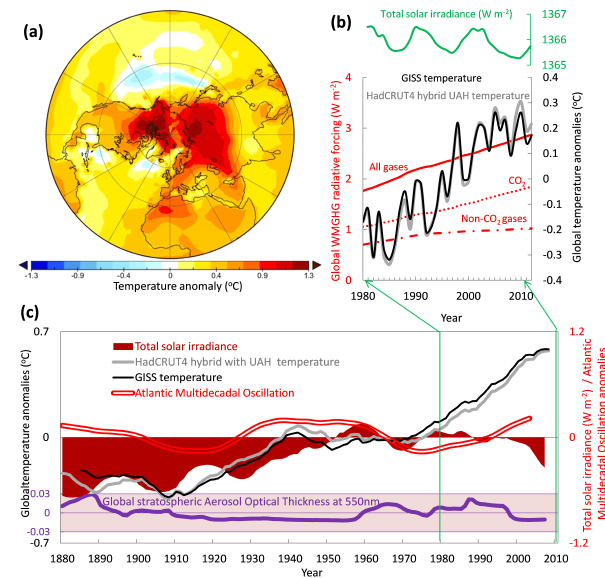
Figure 1. (a) 1980–2012 surface temperature anomaly ( ◦ C) of Northern Hemisphere relative to 1951–1980 base period. (b) The global mean annual surface temperature anomalies, total solar ir- radiance, and global well-mixed greenhouse gases (WMGHG) pat- terns during the satellite era. The WMGHG includes CO 2 , major gases (CH 4 , N 2 O, CFC12 and CFC11) and a set of 15 minor long- lived halogenated gases (CFC-113, CCl 4 , CH 3 CCl 3 , HCFCs 22, 141b and 142b, HFCs 134a, 152a, 23, 143a, and 125, SF 6 , and halons 1211, 1301 and 2402). Global annual mean surface temper- atures relative to 1951–1980 base period from GISS (black) and Cowtan and Way HadCRUT4 hybrid UAH reconstruction (grey), and total solar irradiance are also shown in (b) . (c) 11-year moving averages of global annual mean surface temperatures from GISS and Cowtan and Way HadCRUT4 hybrid UAH reconstruction, total solar irradiance, Atlantic Multidecadal Oscillation (AMO) index, and global stratospheric aerosol optical thickness at 550nm anoma- lies relative to 1951–1980 base period. The zoom-in arrows in (c) show the time period covered in this study when the temperature anomalies diverged from solar forcing and internal climatic vari-